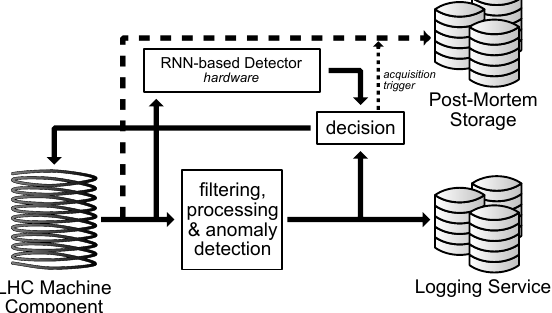
Figure 8. Proposed system. c (cid:13) 2018 IEEE. Reprinted, with permission, from Wielgosz, M.; Skocze´n, A.; Wiatr, K. Looking for a Correct Solution of Anomaly Detection in the LHC Machine Protection